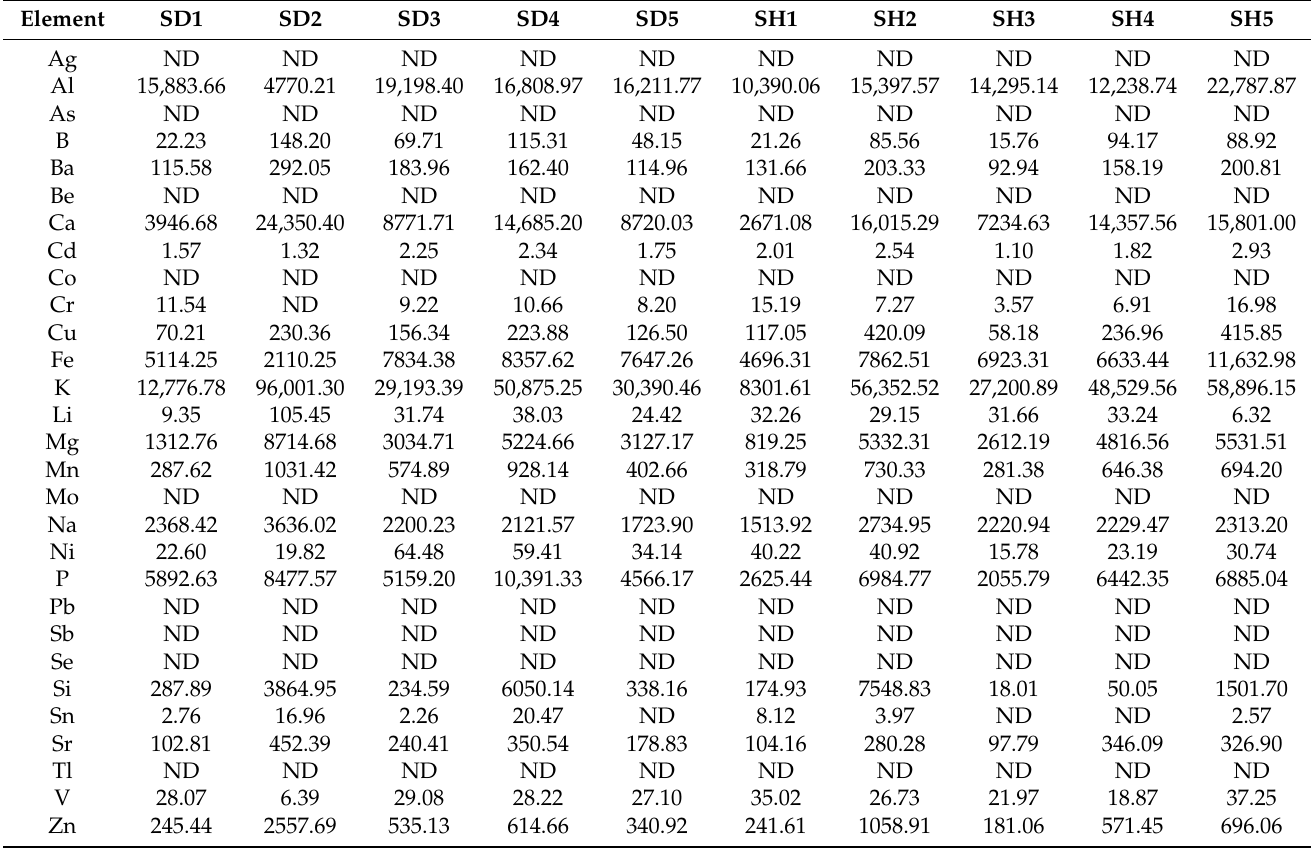
Table 3. Ash microanalysis of sawdust (SD) and shavings (SH) samples